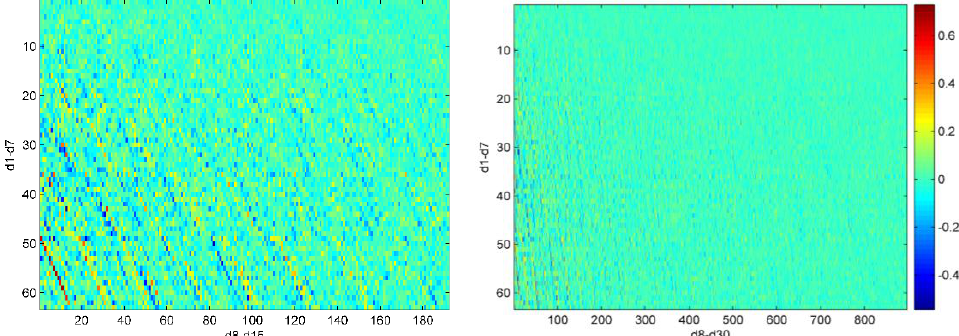
Figure 9. The scaled sensitivity matrix of simulated GPS inversion with a truncation degree of 7. The horizontal axis is arranged in order of ∆ T C